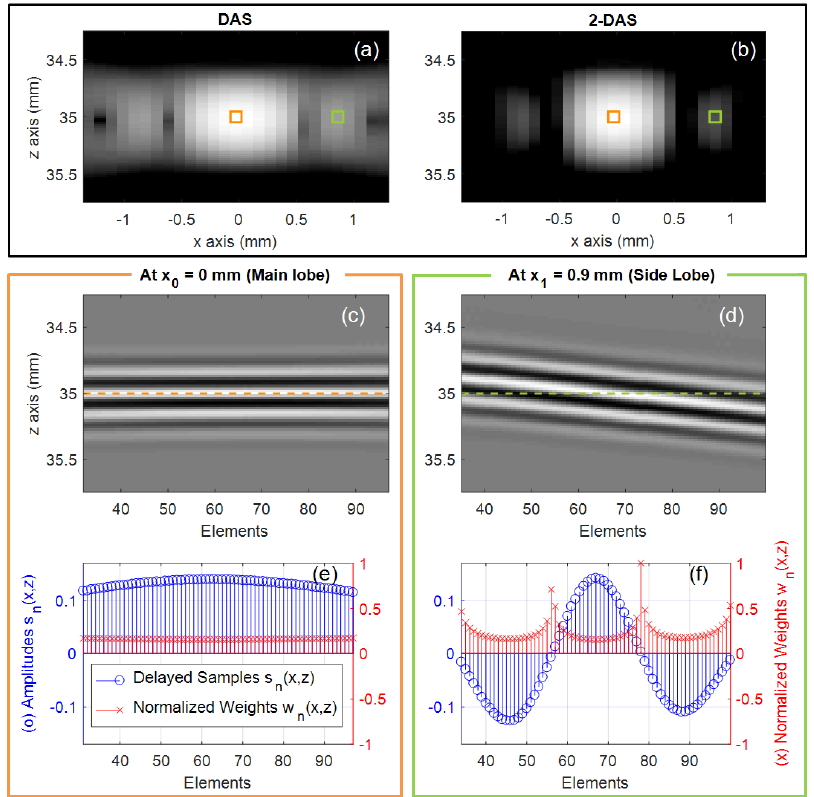
Figure 3. Illustration of the enhanced side-lobe rejection for the point spread function (PSF) with the proposed method with p = 2 (2-DAS), compared with conventional DAS. The scatterer placed at ( x 0 = 0 mm, z 0 = 35 mm) on the numerical phantom is considered. The B-mode log-compressed images with a 40-dB dynamic range are shown for DAS ( a ) and 2-DAS ( b ). The delayed signals s n ( x , z ) are shown for x 0 = 0 mm ( c ) and x 1 = 0.9 mm ( d ); ( e ) the delayed samples s n ( x 0 , z 0 ) for the pixel on the main lobe are shown in blue, with their corresponding adaptive weights w n ( x 0 , z 0 ) in red; and ( f ) the delayed samples s n ( x 1 , z 0 ) for the pixel on the side lobe are shown in blue, with their corresponding adaptive weights w n ( x 1 , z 0 ) in